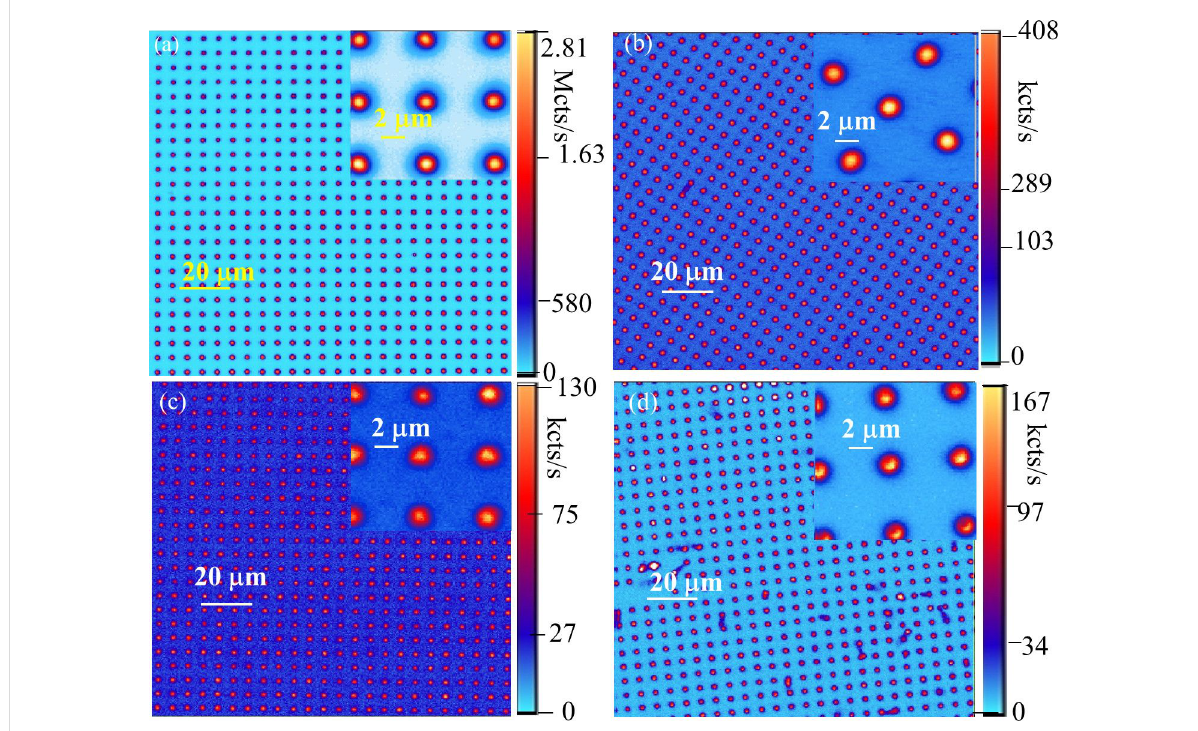
Figure 5: Confocal image and zoom image of a 10 × 10 µm 2 V Si fluorescent micropillar array excited by a 730 nm laser. (a) Sample 1 excited by 30 µW laser power. (b) Sample 2 excited by 0.7 mW laser power. (c) Sample 3 excited by 1.5 mW laser power. (d) Sample 4 excited by 4.3 mW laser power. An Olympus 0.85 NA infrared objective was